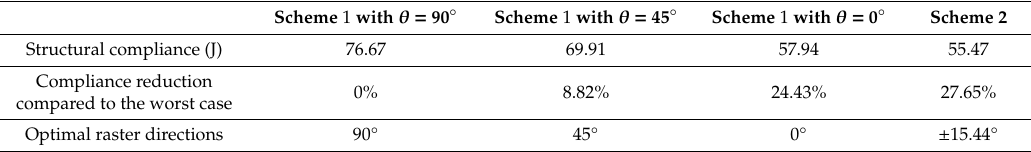
Figure 6. Cantilever optimization results (the blue color shows the converged ρ e 1 = 1 , the red color shows the converged ρ e 2 = 1 , and the green color shows the misconverged or void areas). Table 1. Data of The Cantilever Optimization Results.